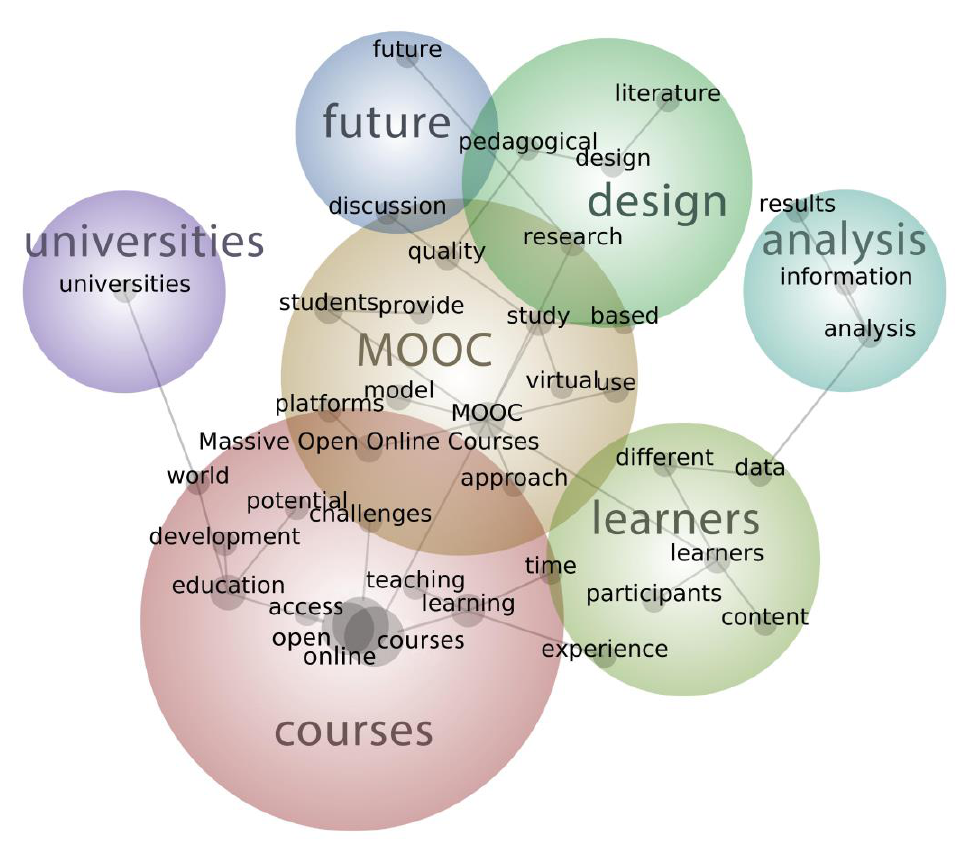
Figure 3. Concept map of research articles on MOOCs